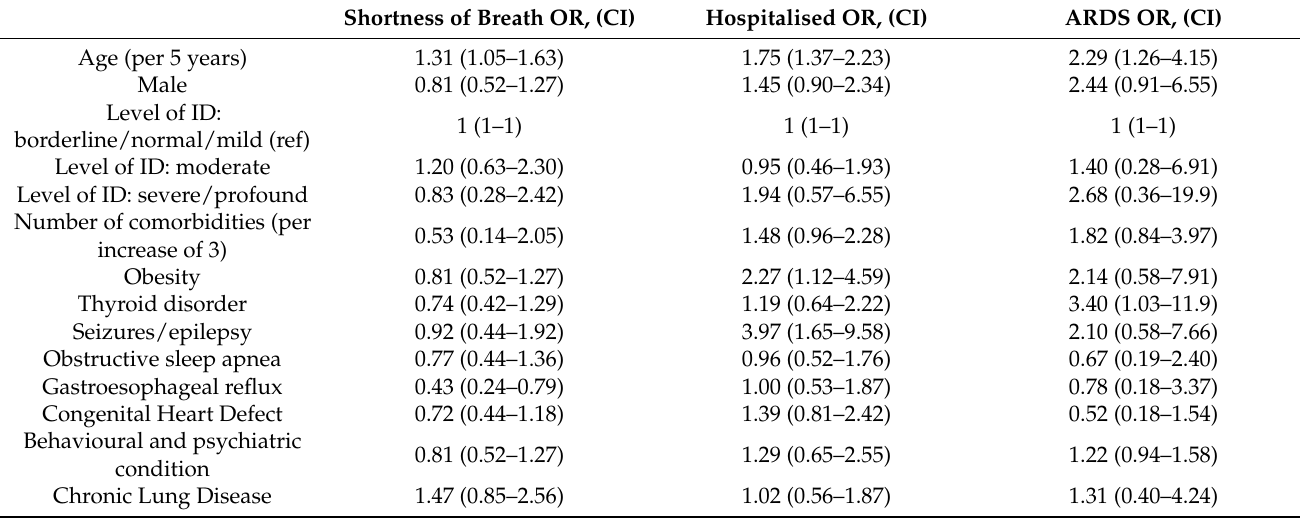
Table A6. Data entered into the database during a later phase of the pandemic (October 22 to August 2, 2021). Medical complications among hospitalised individuals with and without Down Syndrome stratified by high-income and low to middle-income countries.